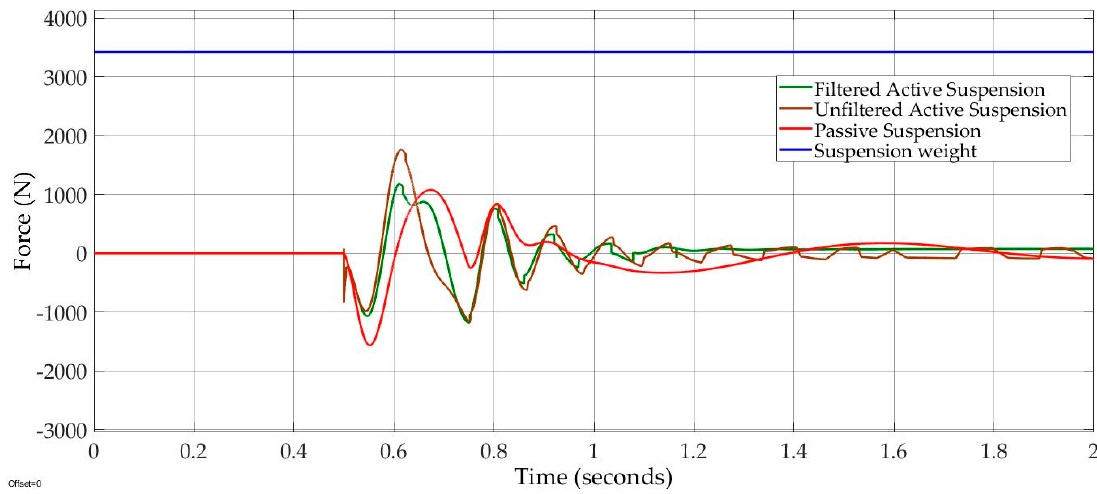
Figure 7. Road holding of Case 1.